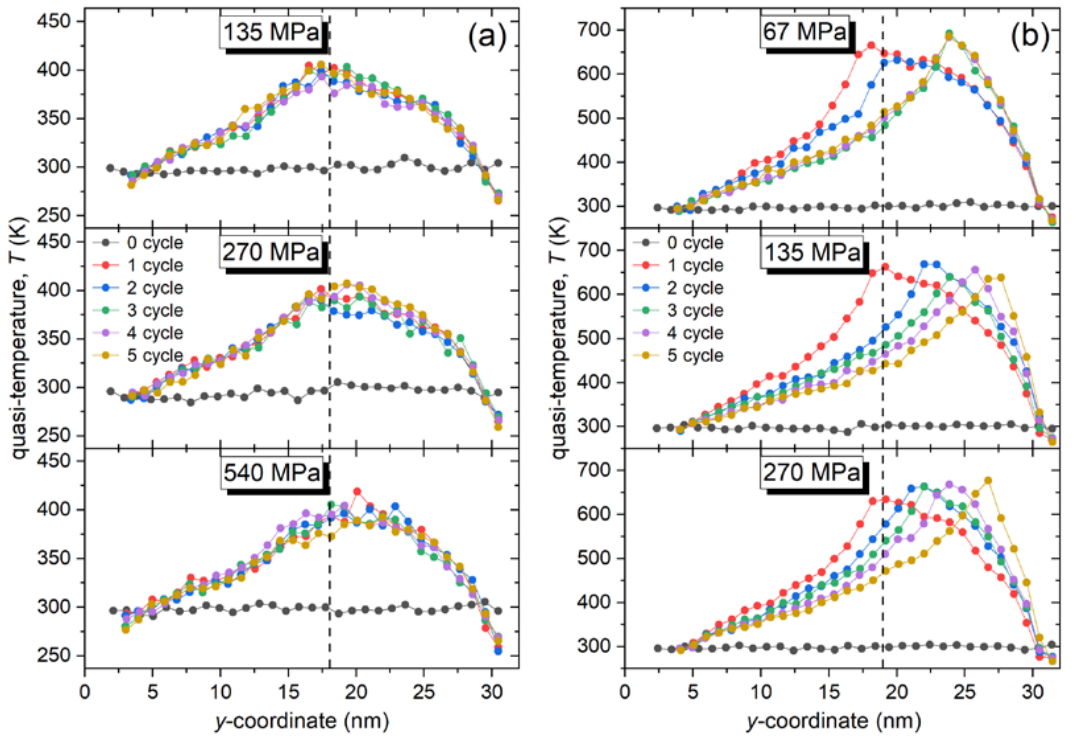
Figure 6. Quasi-temperature profiles in Model I ( a ) and Model II ( b ) during simulated USW under various applied clamping pressures and at different cycles of sliding (shown in legend). The vertical dashed lines show the centers of the computational cells. The lines connecting the data points are guides to the eye.